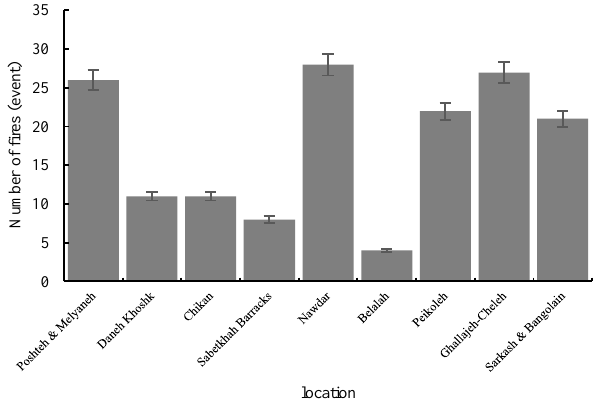
Figure 4 : Indicative areas for the frequency of fires from 2011 to 2020 The highest monthly fires frequency during the fire season months includes 53, 44, and 40 events, which concern August, July, and September, respectively. The lowest monthly fires rate includes 1 and 3 events, which happen in May and December, respectively (Figure 5).